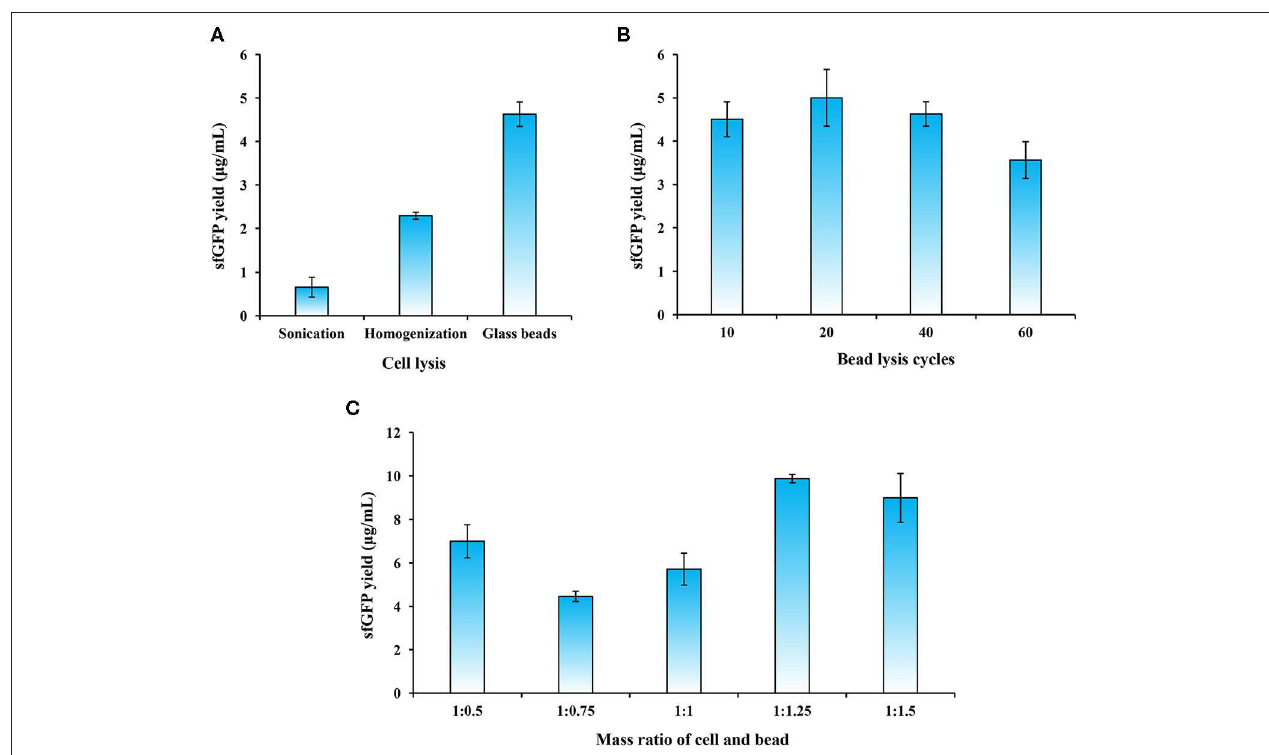
FIGURE 2 | Optimization of cell extract preparation. (A) Evaluation of three cell lysis methods. (B) Effects of bead lysis cycles on cell extract activity. (C) Optimization of the mass ratio of cell and bead (g/g) on sfGFP synthesis. Values show means with error bars representing standard deviations (s.d.) of at least three independent